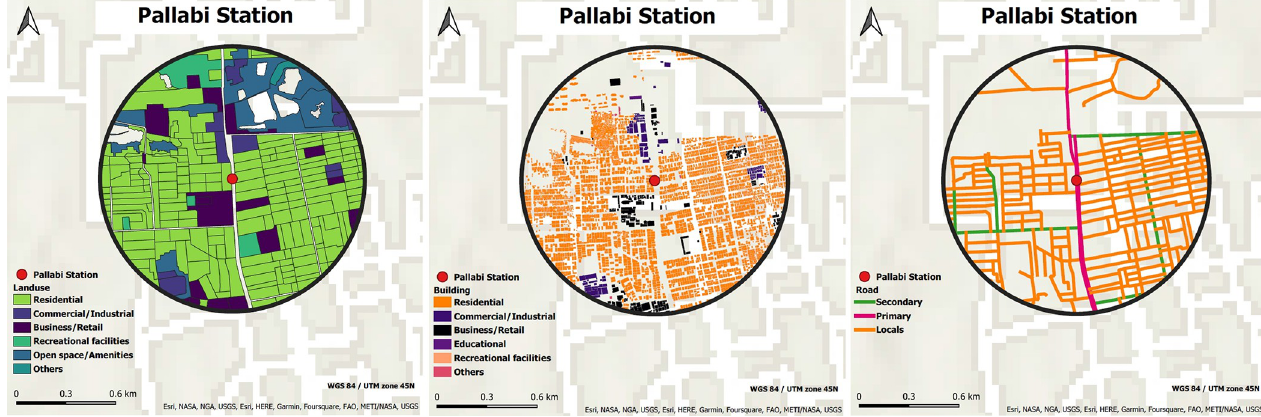
Fig 3. Vector maps of Pallabi station’s buffer: (a) Land use (Source: https://datacatalog.worldbank.org/search/dataset/0039604, CC BY- 4.0 and https://apps. nationalmap.gov/viewer), (b) Building footprint (Source: https://apps.nationalmap.gov/viewer), and (c) Road network (Source: https://datacatalog.worldbank. org/search/dataset/0042062, CC BY- 4.0 and https://apps.nationalmap.gov/viewer).